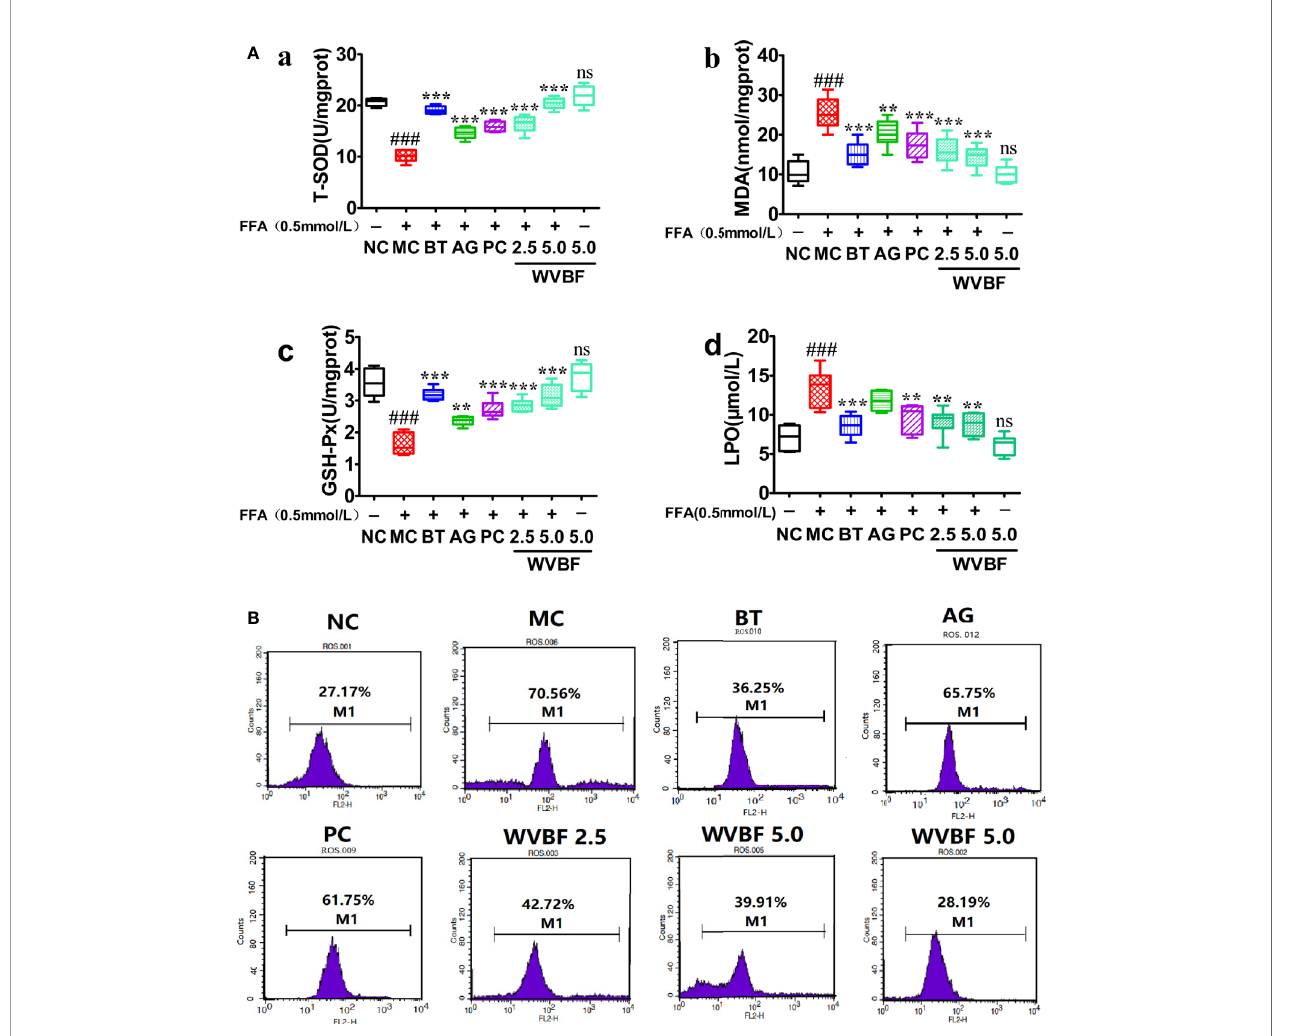
FIGURE 7 | Effects of water extract of Veratrilla baillonii (WVBF) on free fatty acids (FFA)-induced oxidative stress and intercellular reactive oxygen species (ROS) production in LO2. (A) Effects of WVBF pre-treatment on T-SOD (a), MDA (b), GSH-Px (c), LPO (d) product in LO2. (B) Flow cytometry analysis of FFA-induced ROS. n =3 ( n , the number of experiments), ( ## P < 0.01, ### P < 0.001 vs . control group; * P < 0.05, ** P < 0.01, and *** P < 0.001 vs . FFA